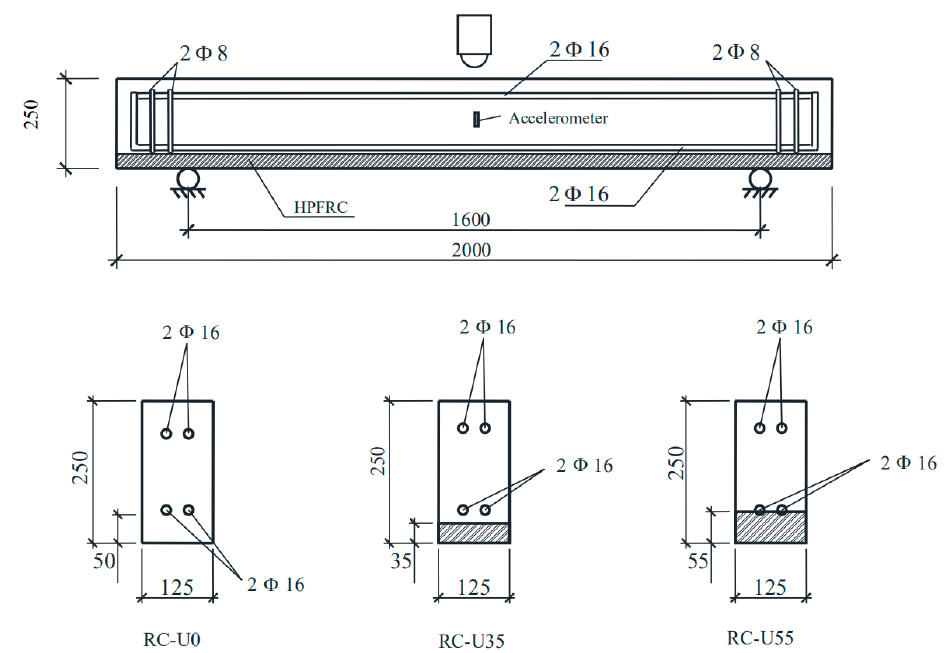
Figure 1. Test set-up and geometry of specimens (dimensions in mm).